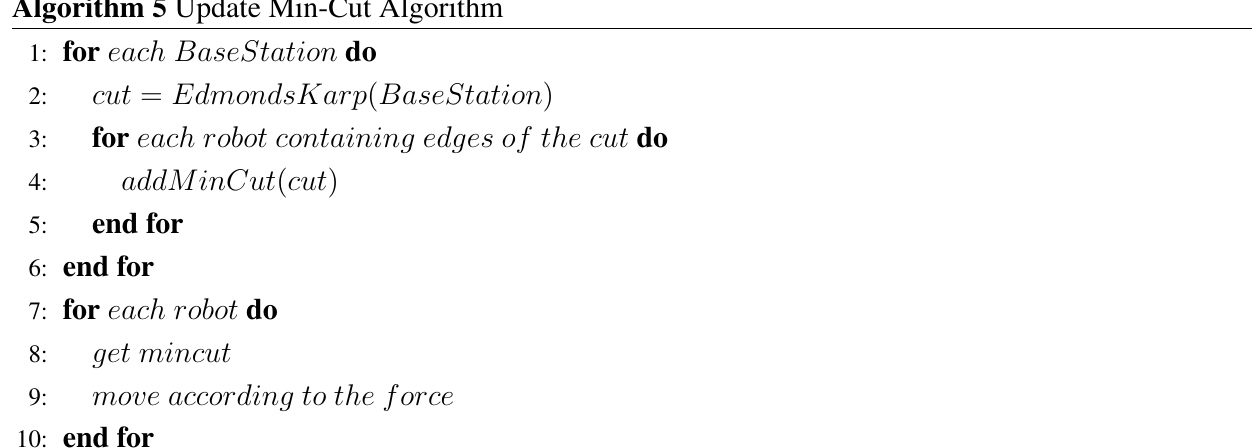
Algorithm 5 Update Min-Cut